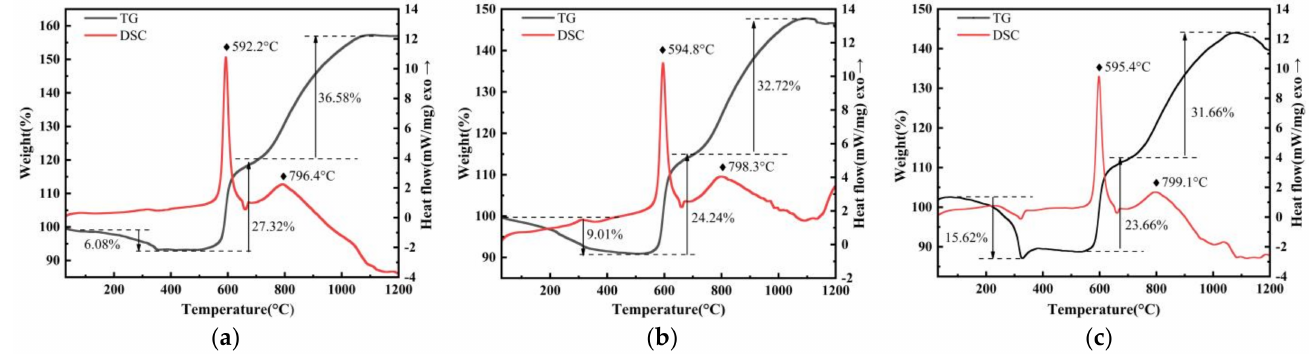
Figure 6. TG-DSC curves of ( a ) nAl@2.5%PFPE particles, ( b ) nAl@5.0%PFPE particles, ( c ) nAl@7.5%PFPE